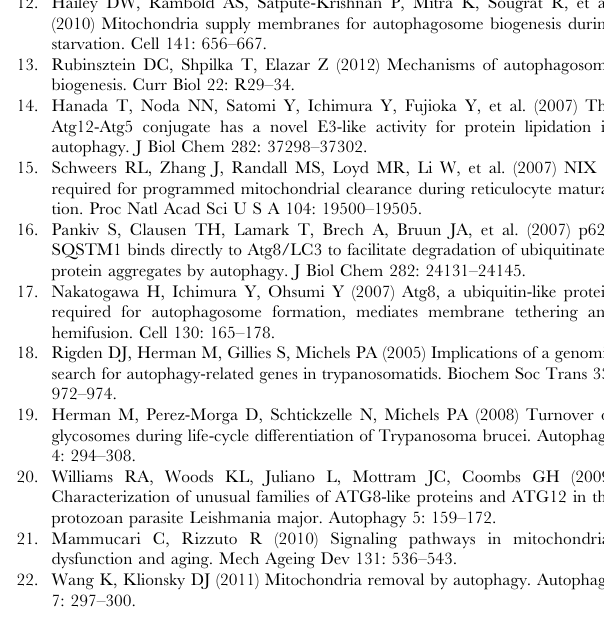
labelled. Molecular size markers are shown on the left (kb).